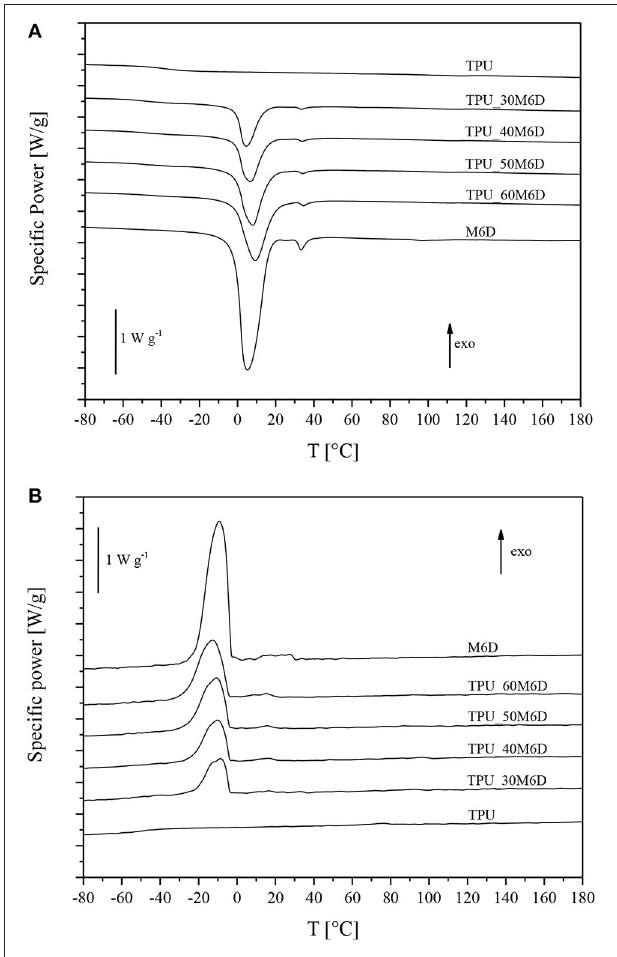
FIGURE 2 | DSC thermograms of neat TPU, M6D capsules and their relative blends. (A) Heating scan and (B) cooling scan.